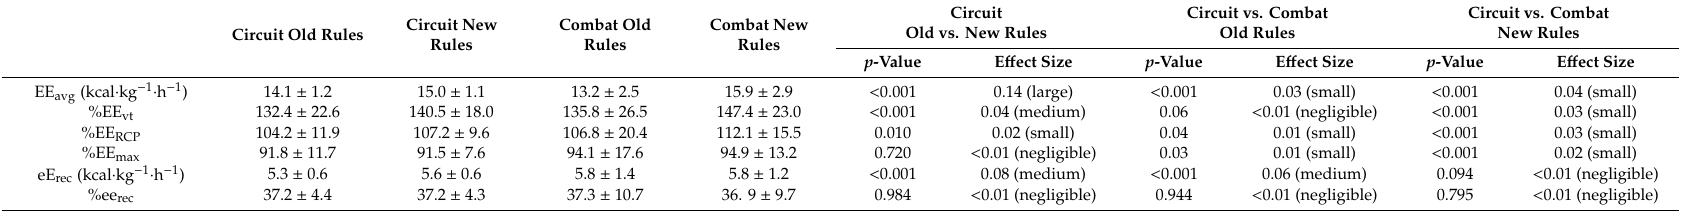
Table 4. Energy expenditure during taekwondo-specific circuit training and combat—comparison between old and new rules. Circuit Old Rules Circuit New